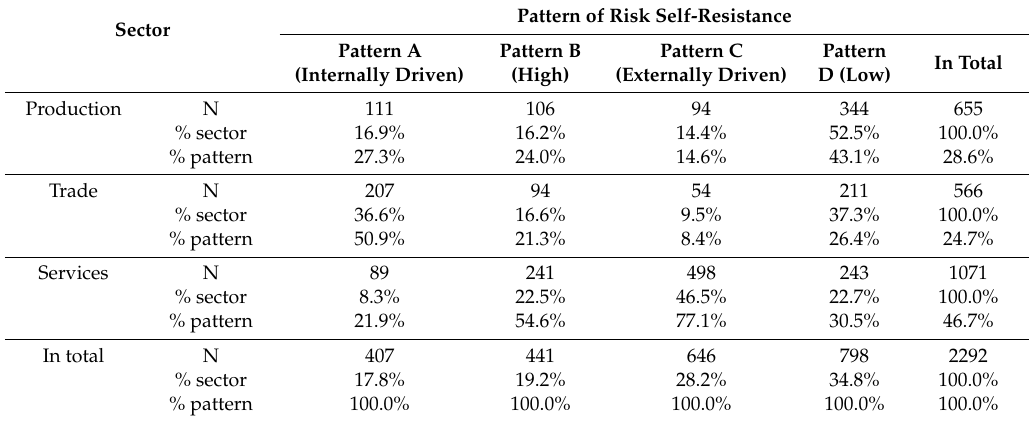
Table 3. Pattern of risk-self resistance by sectors of observed companies.